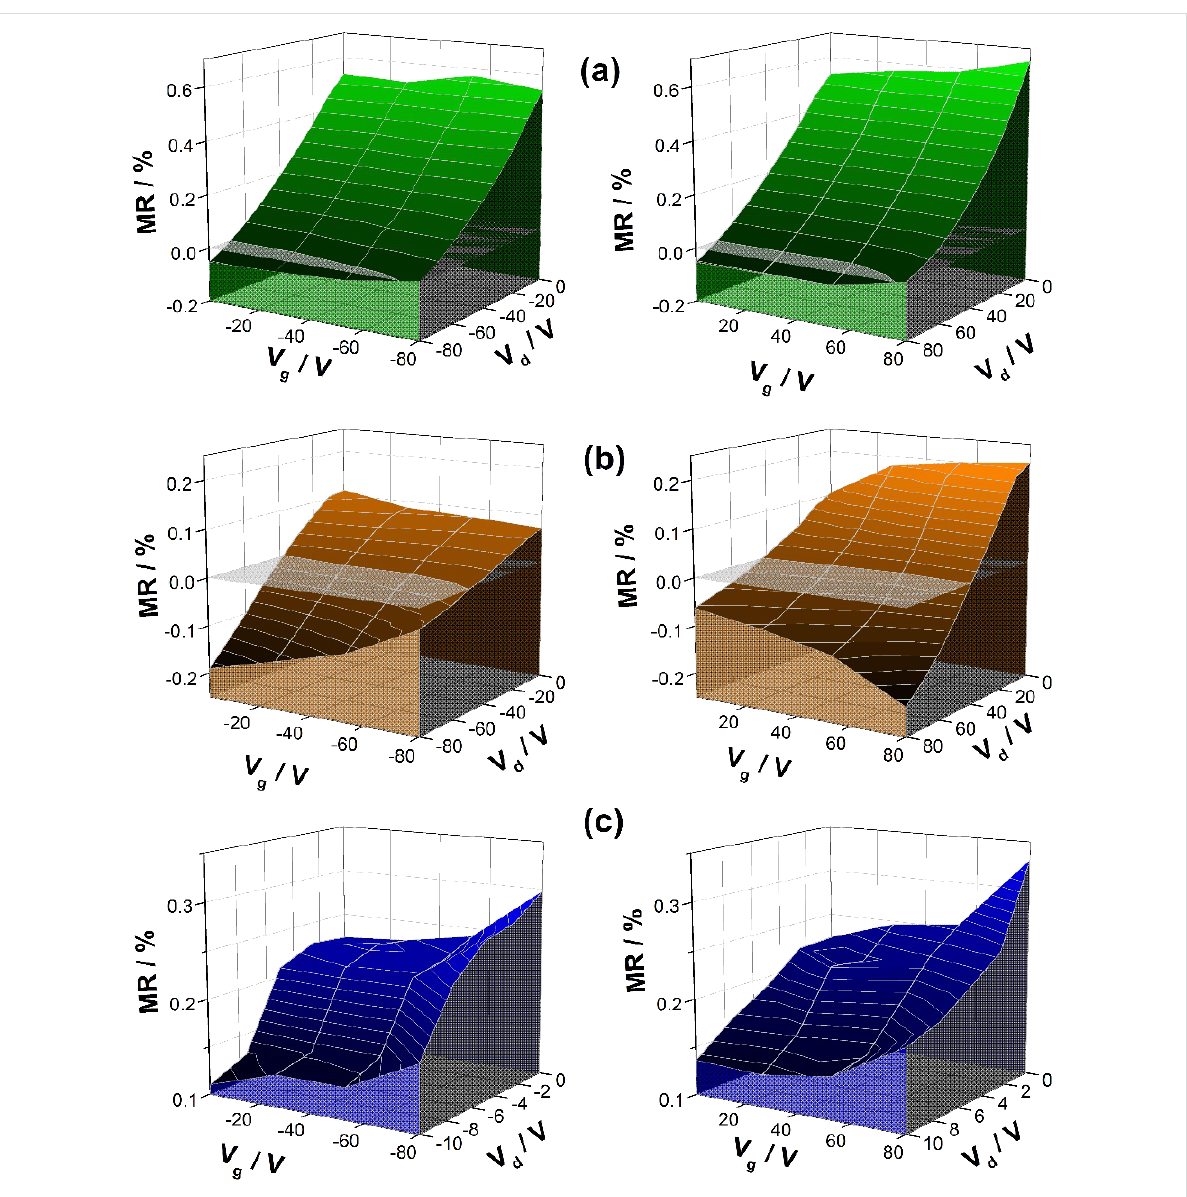
Figure 2: Voltage dependence ( V d and V g ) of the magnetoresistance for compositions of (a) 51:49, (b) 78:22 and (c) 21:79. On the left side, p -channel conditions are shown, while n -channel conditions are depicted on the right side. In order to allow a continuous 3D representation of the explored magnetoresistance landscape, the Renka–Cline fit was used to interpolate between all experimental data points. The underlying experimen- tal data is displayed in Supporting Information File 1, Figure S2 [19]. The inserted grey-shaded plane serves to illustrate the voltage-induced sign reversal. All measurements were carried out for B = 60